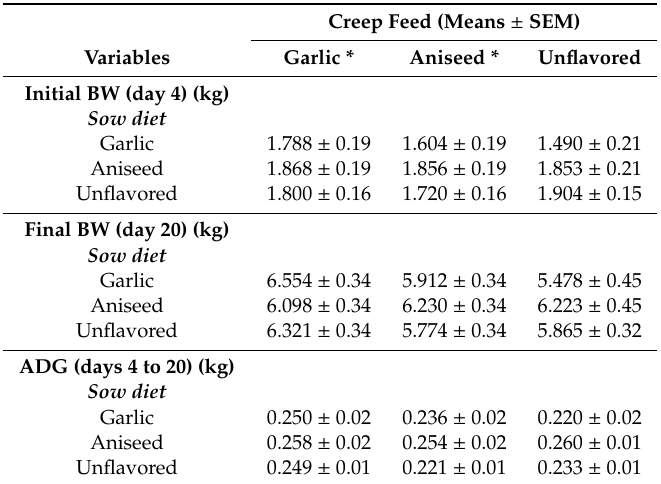
Table 1. Body weight (BW) and average daily gain (ADG) of suckling piglets according to flavors added to late-gestation maternal diets (91–114 days) and creep feed diets (from age 10 days old onwards).